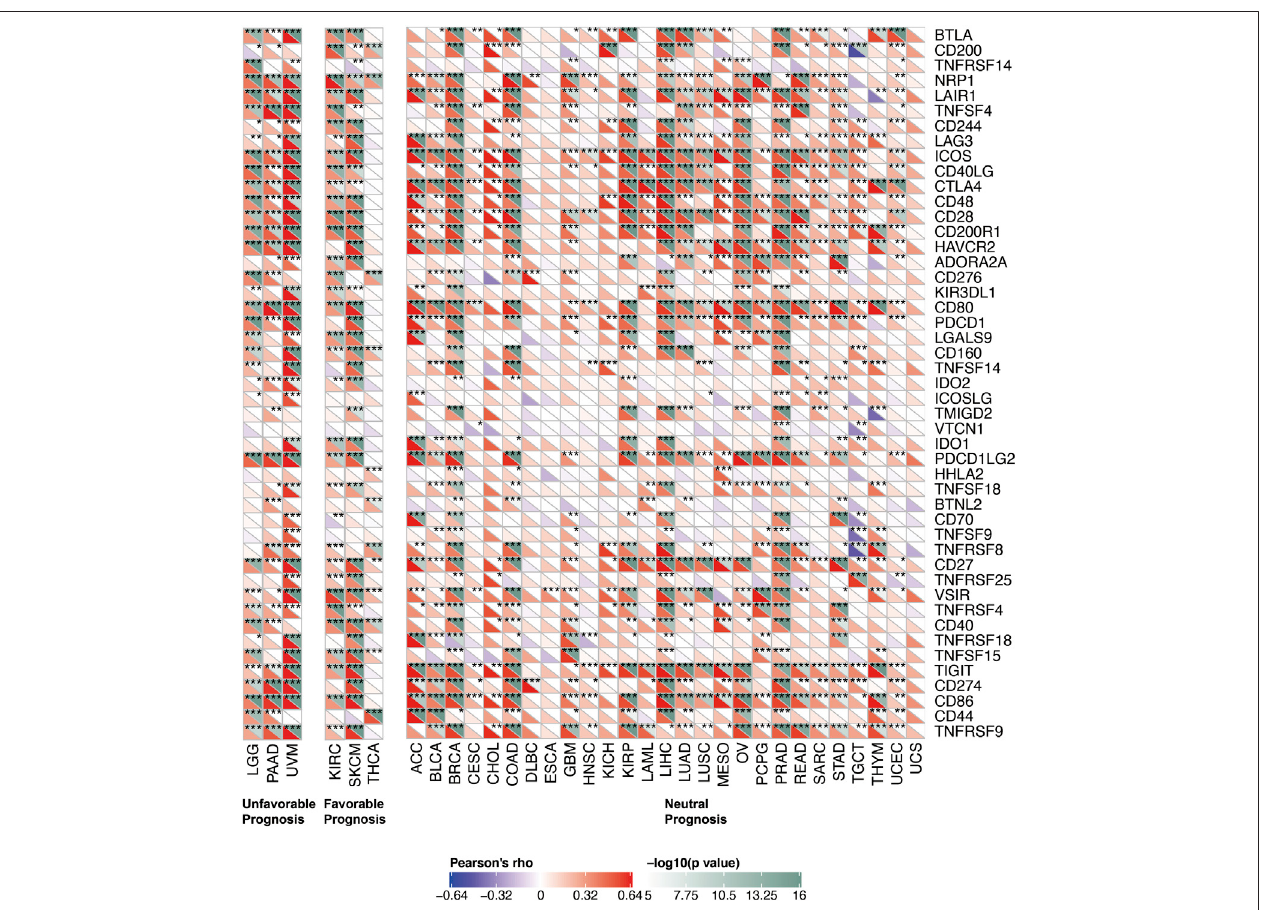
FIGURE 5 | Correlation of PRDM1 expression with expression of immune checkpoint genes across 33 cancer types.